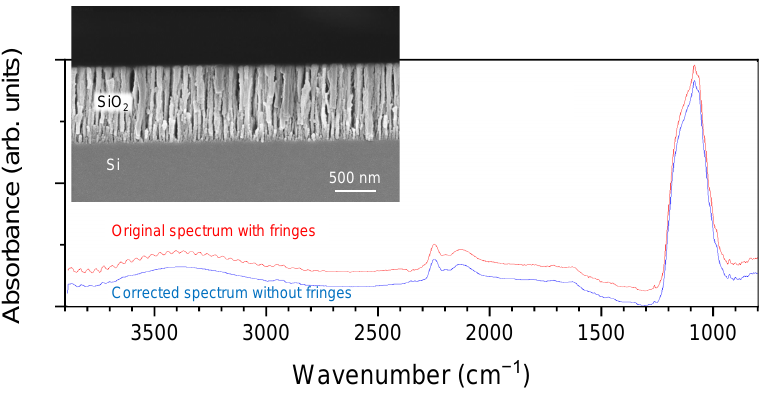
Figure A1. Fringe removal from Si-on-CaF 2 spectra by the method presented in Ref. [29]; plotted with vertical offset for clarity. The inset shows a cross-sectional SEM view of SiO 2 -on-Si prepared in the same conditions; a better quality cleaving of the sample can be achieved on the Si substrate; the sample was cleaved along the fast-axis.